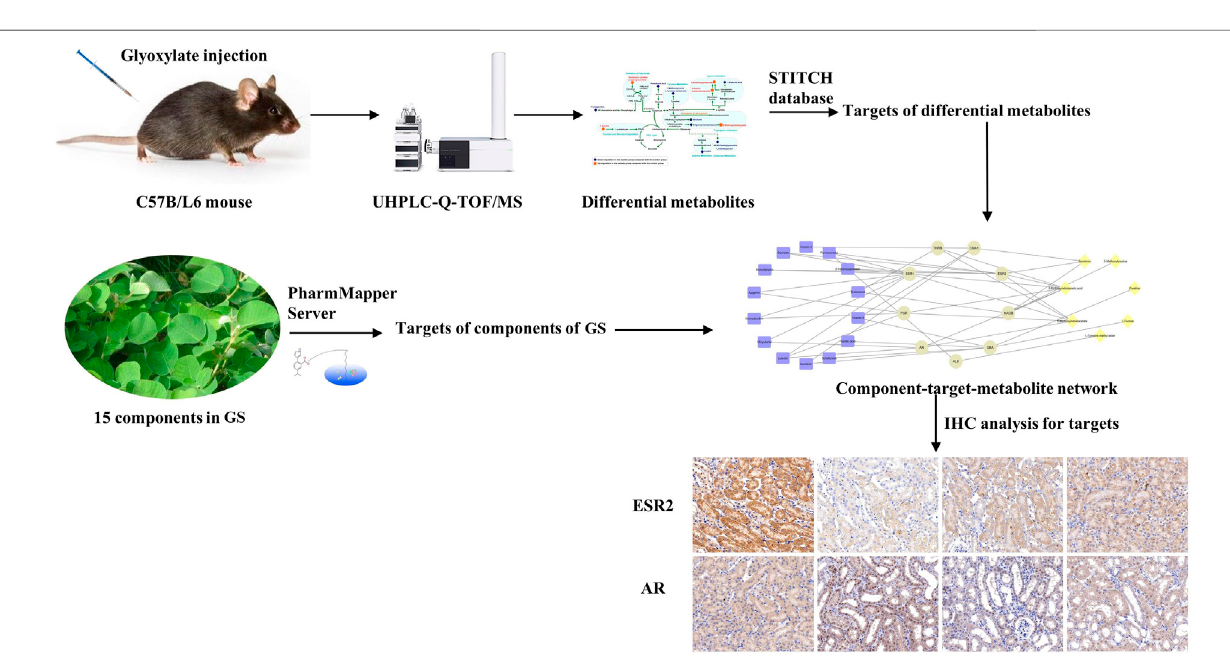
Frontiers in Pharmacology |